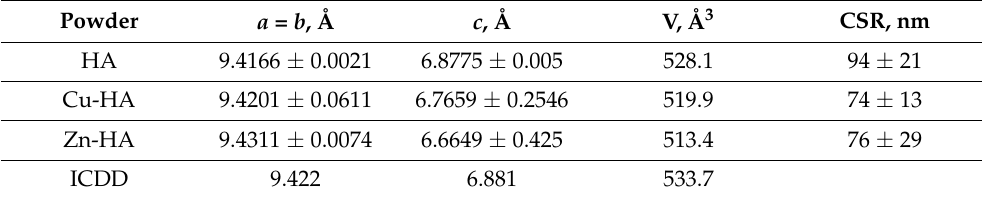
Table 1. Results of X-ray diffraction analysis of powders of HA, Cu-HA, and Zn-HA.